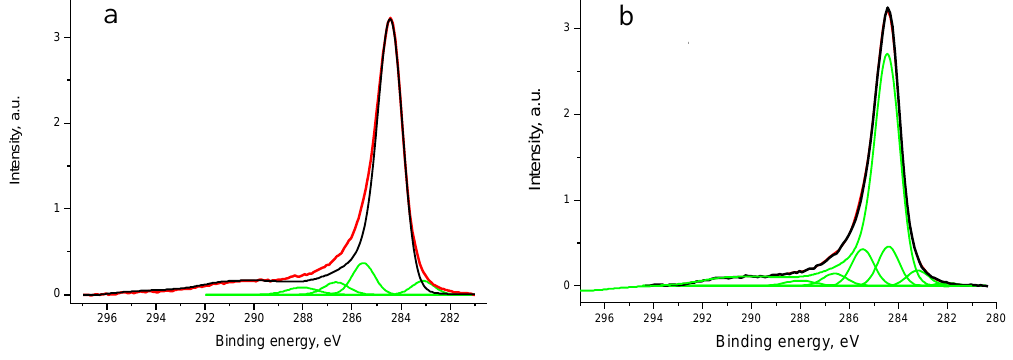
Figure 17. The C 1s photoelectron spectra of samples 3 ( a ) and Pt / 3 ( b ).